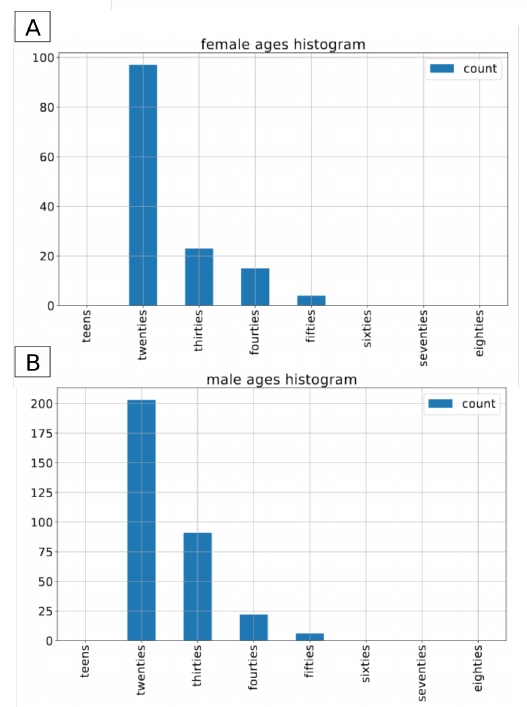
Figure 5. TIMIT: age distribution by gender in the validation dataset. ( A ) female speakers, ( B ) male